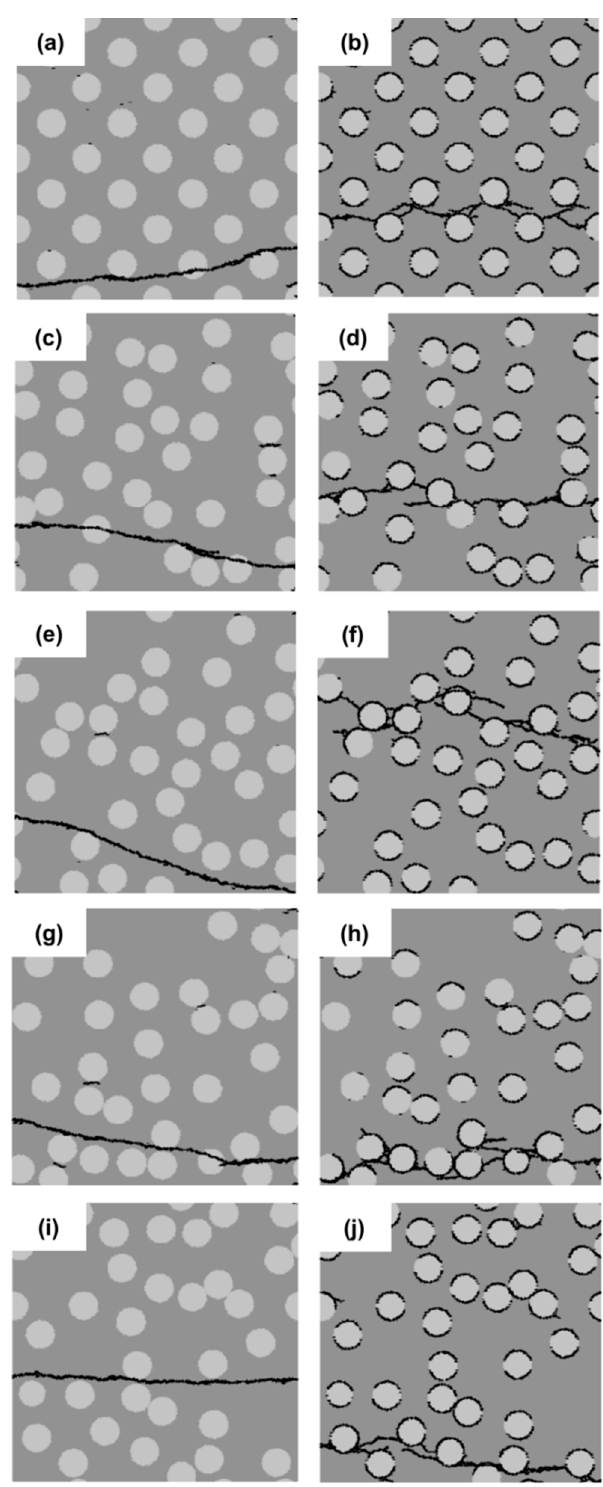
Figure 4. Micro-crack patterns of specimens with a strong interface (left) and a weak interface (right) for five different filler particle distributions (Distribution 1 ( a , b ), Distribution 2 ( c , d ), Distribution 3 ( e , f ), Distribution 4 ( g , h ) and Distribution 5 ( i , j )).